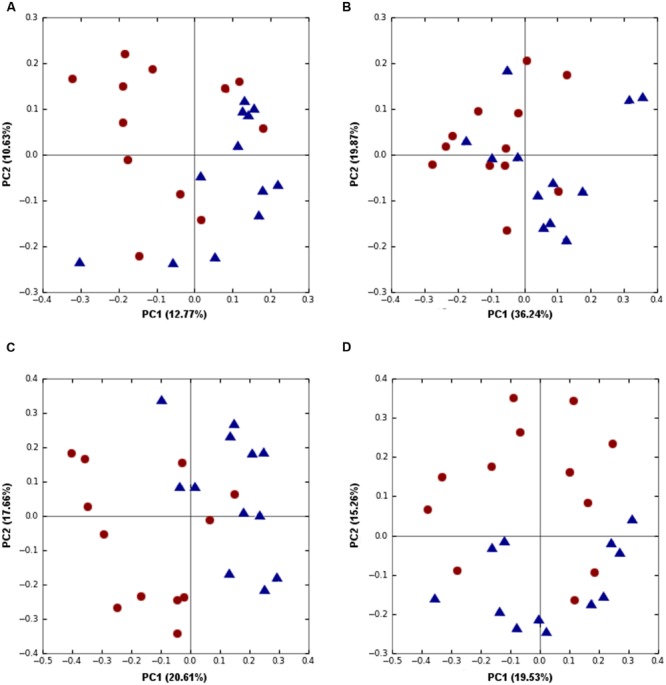
Trial 2 beta diversity was significantly different between high (red) and low (blue) FCR birds microbial communities. (A) Unweighted (p = 0.0019) and (B) Weighted Unifrac (p = 0.0072) at an OTU level as well as Canberra beta diversity at a (C) genus (p = 0.0055) and (D) family (p = 1.8E-4) levels were separating high and low FCR birds.